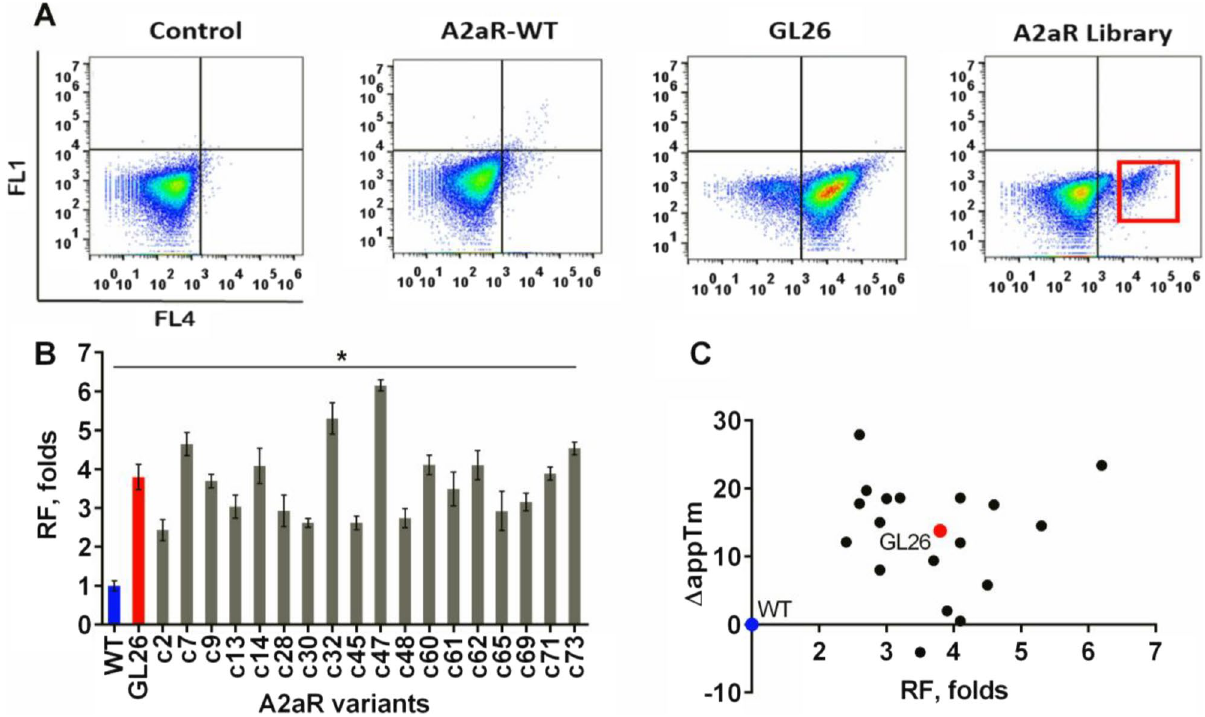
Figure 4. YDDS retrieves A2aR variants with various stability profiles. ( A ) Permeabilized yeast expressing A2aR-WT, GL26 mutant or library of A2aR mutants were preincubated with 20 nM CA200623 for 1 h, treated with 2% OG for 4 h (see “Methods”), and analyzed by FACS. FL4-APC channel was used to detect CA200623 fluorescence, while FL1-FITC channel (negative control) was added for the dot plot generation. Cells not expressing any receptor were used as control. The red square outlines the unique cell population present in the A2aR library, which remained fluorescent after OG treatment. ( B ) Encoding DNA isolated from the OG resistant cell population present in the A2aR library (red square in (A) ) was reintroduced into yeast by a homology recombination, followed by the OG resistance analysis of randomly selected clones using flow cytometry, as described in ( A ). Eighteen clones with the highest residual florescence after OG treatment, RF (geometric MFI across the population, relative to that of A2aR-WT), were selected for further analyses. The RF values reported are the mean ± SE of three independent experiments performed in triplicate. An unpaired parametric t-test was used to evaluate the significance of the differences between A2aR-WT and OG resistant variants. Statically significant differences were found between all the groups compared, * p < 0.005. ( C ) The Pearson correlation analysis detects no correlation between the extent of thermostabilization (ΔappTm) determined by the whole-yeast thermostability assay and RF. The A2aR-WT and GL26-expressing yeast are indicated as blue and red dots, respectively. To construct the plot, the mean values of ΔappTm and RF of three independent experiments were